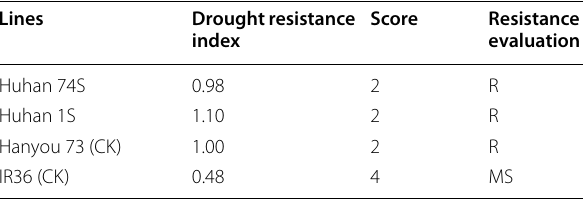
Table 3 Evaluation of drought resistance of Huhan 74S and Huhan